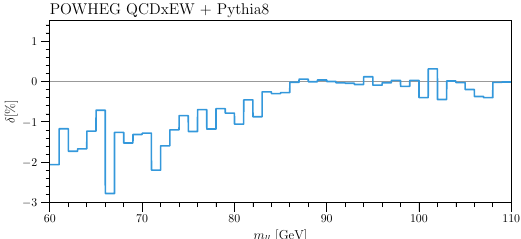
Figure 6 : The plot shows the relative di(cid:11)erence in the prediction of the invariant-mass distribution using the simple matching, where the Powheg scale is the starting scale of the shower, with respect to the vetoed shower as described in the text. Here, we have employed S M , however, the result does not depend on the S functions in a signi(cid:12)cant way.